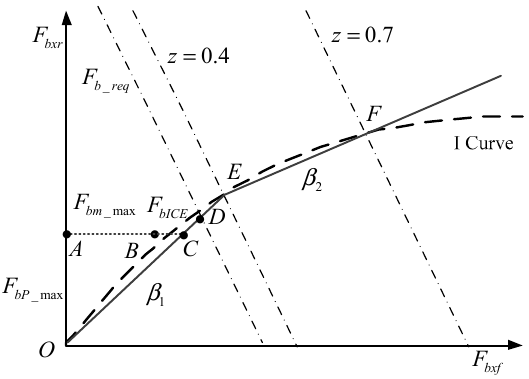
Figure 4. The braking force distribution curve. ( F bxf ) Braking force in the front axle; ( F bxr ) braking force in the rear axle; (I curve) the ideal braking force distribution curve.